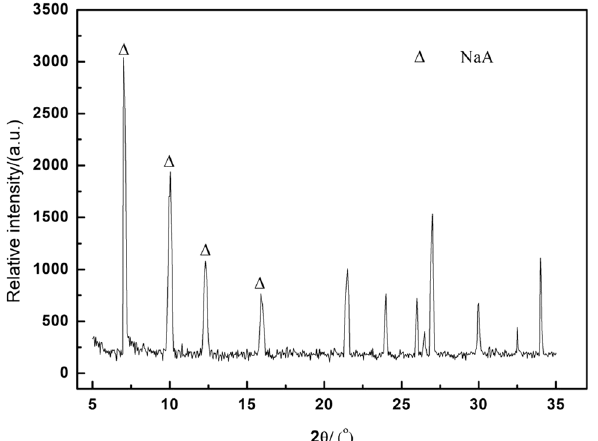
Fig. 10 XRD of zeolite NaA membrane that formed on the sample sintered at temperatures of 1500